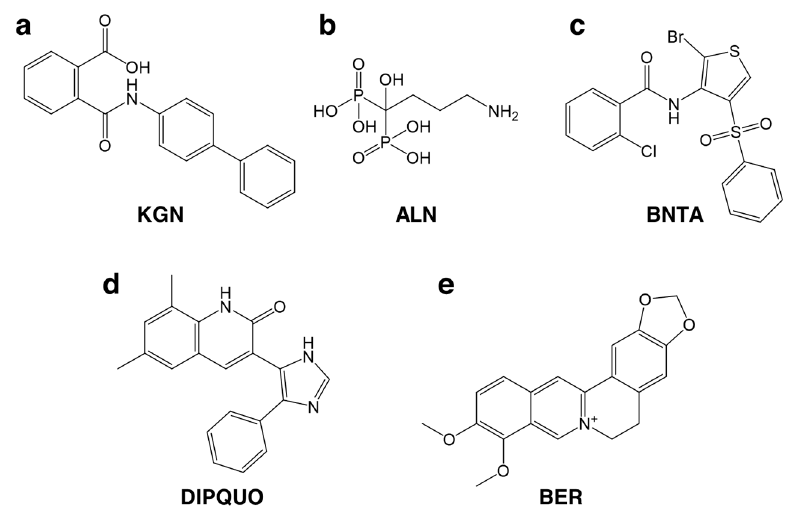
Figure 3. Small molecule drugs used for OC therapy. ( a ) Kartogenin (KGN). ( b ) Alendronate (ALN). ( c ) N -[2-bromo-4-(phenylsulfonyl)-3-thienyl]-2-chlorobenzamide (BNTA). ( d ) 6,8-dimethyl-3-(4-phenyl-1 H -imidazol-5-yl)quinolin-2(1 H )-one (DIPQUO). ( e ) Berberine (BER).